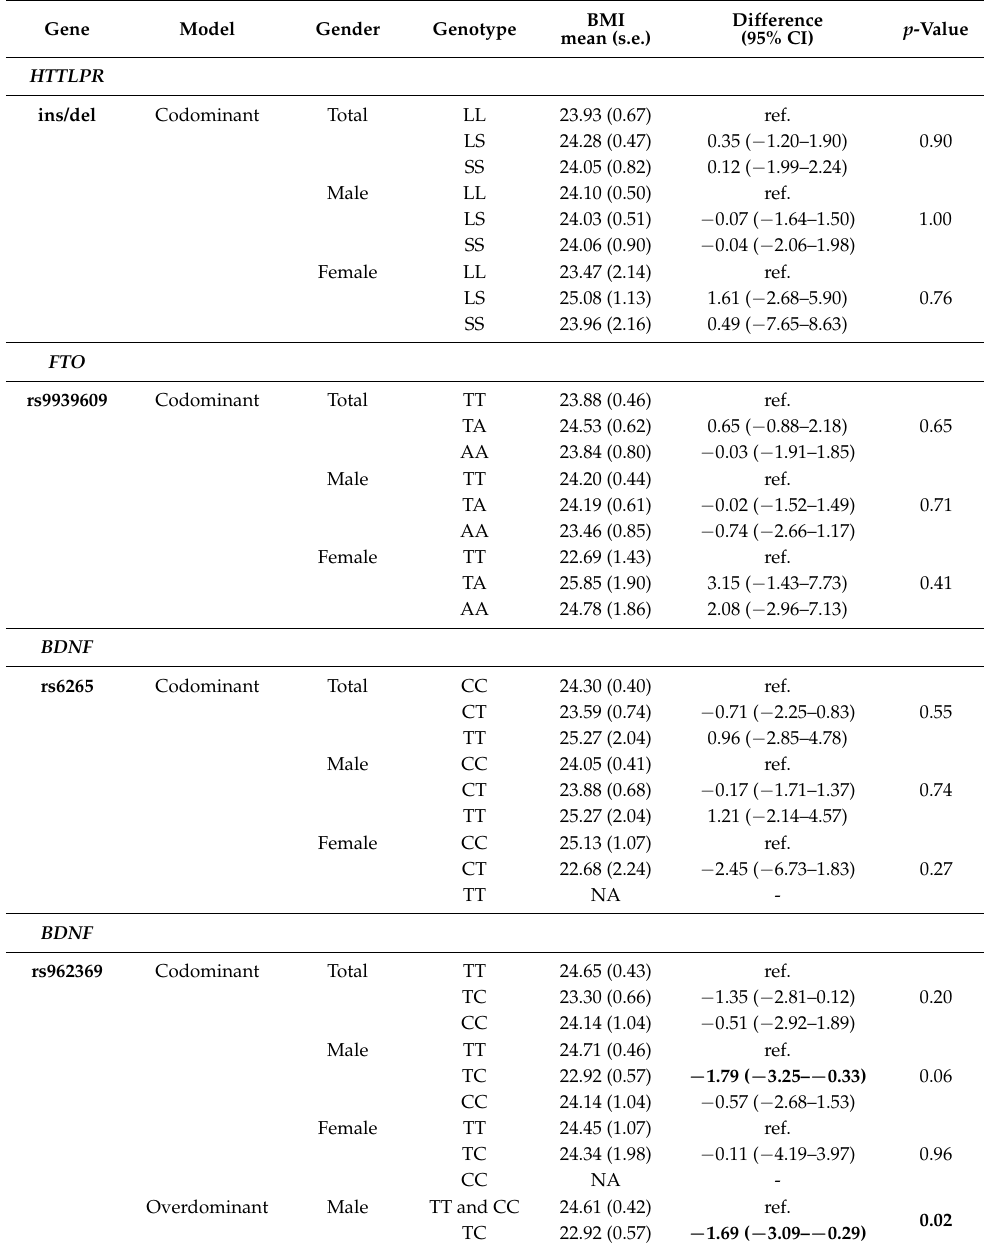
Table 6. Analysis of the association between four gene variants and BMI in suicide cases. Gene Model Gender Genotype